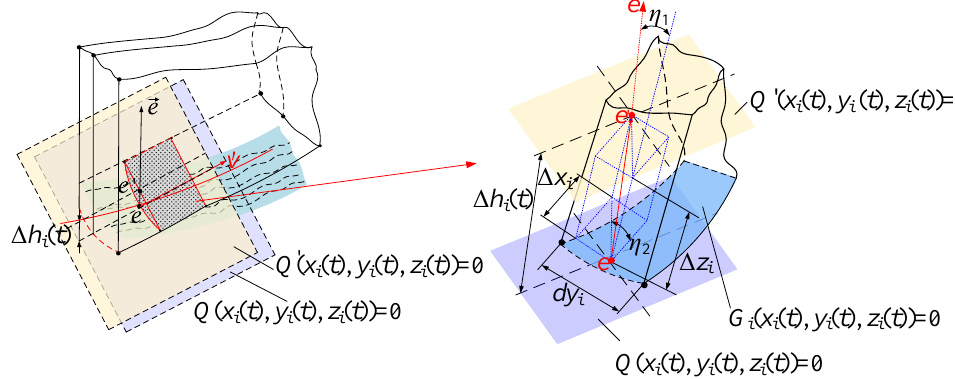
Figure 2. Instantaneous wear depth of the tool flank after micro-element of cutter tooth. Table 1. Illustration of instantaneous milling process variables of high-feed milling cutter under vibration.